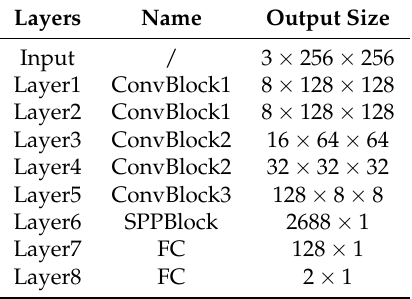
Figure 2. Inception module with residual connection. Table 1. The architecture of the